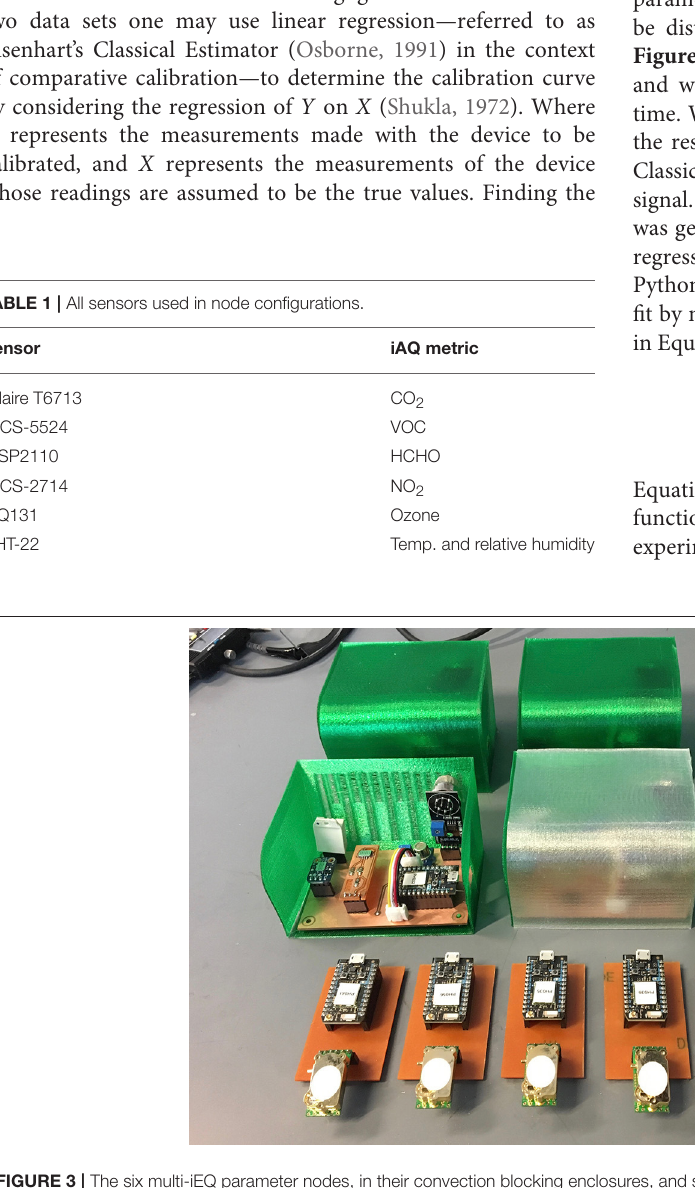
Frontiers in Built Environment |